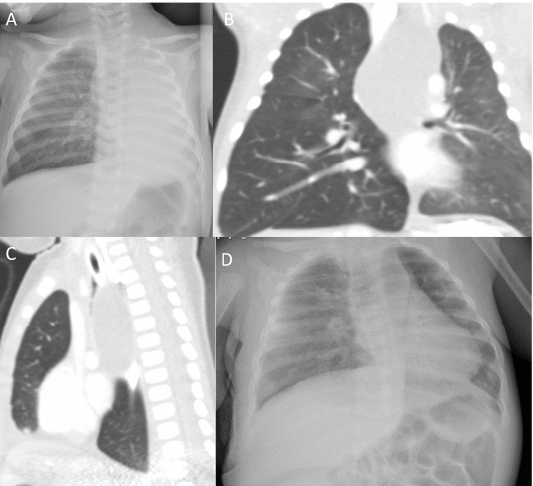
Figure 1. Chest X-ray (CXR) and chest computed tomography (CT) findings in case 1: ( A ) CXR of the patient on admission shows right lung hyperlucency, complete collapse on the left side, and marked left-sided mediastinal shift. ( B,C ) Coronal and sagittal windows, lung view; CT images of the chest reveal a well-defined cystic lesion in the posterior mediastinum at the level of the left apical lobe extending downward to the level below the carina with fluid density. The mass lesion attaches to the adjacent vessels and compresses the aortic arch, the descending aorta to the left side, and the inferior vena cava to the right side. The lesion shifts the esophagus to the right side with no obvious communication. ( D ) CXR of the patient at 1-month postoperative follow-up showing a well-aerated lung.